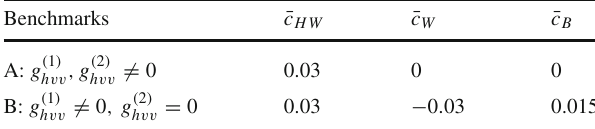
Table 3 EFT benchmark points under consideration, with (cid:5) = m W . We additionally set ¯ c BB = ¯ c HB = 0 for simplicity